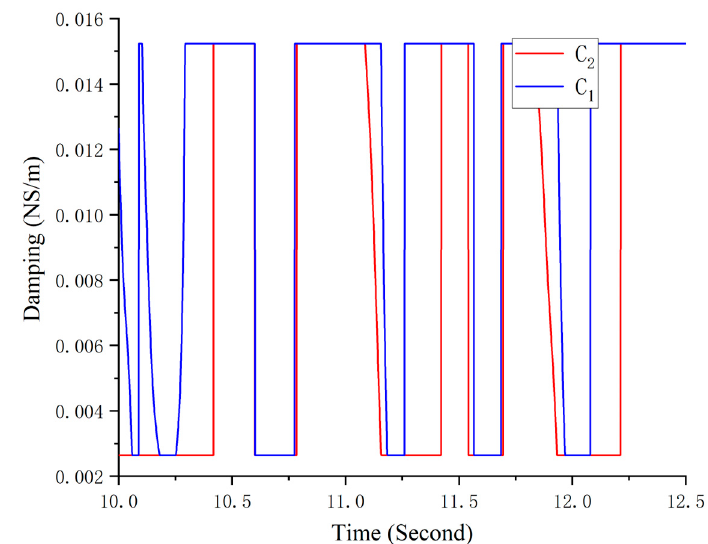
Figure 20. The damping of VEI–VD device.